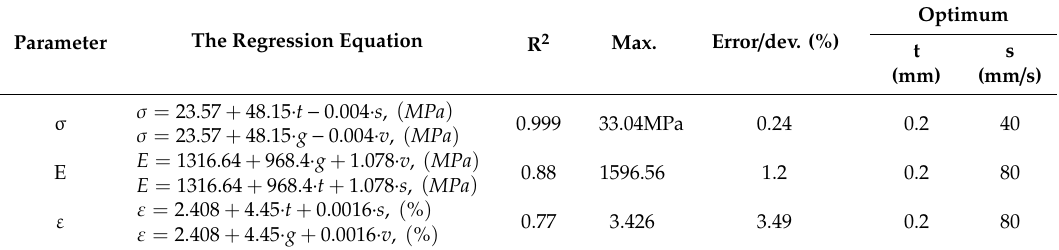
Table 5. Results regarding the technological parameters optimization for the Extrudr BDP Flax printed